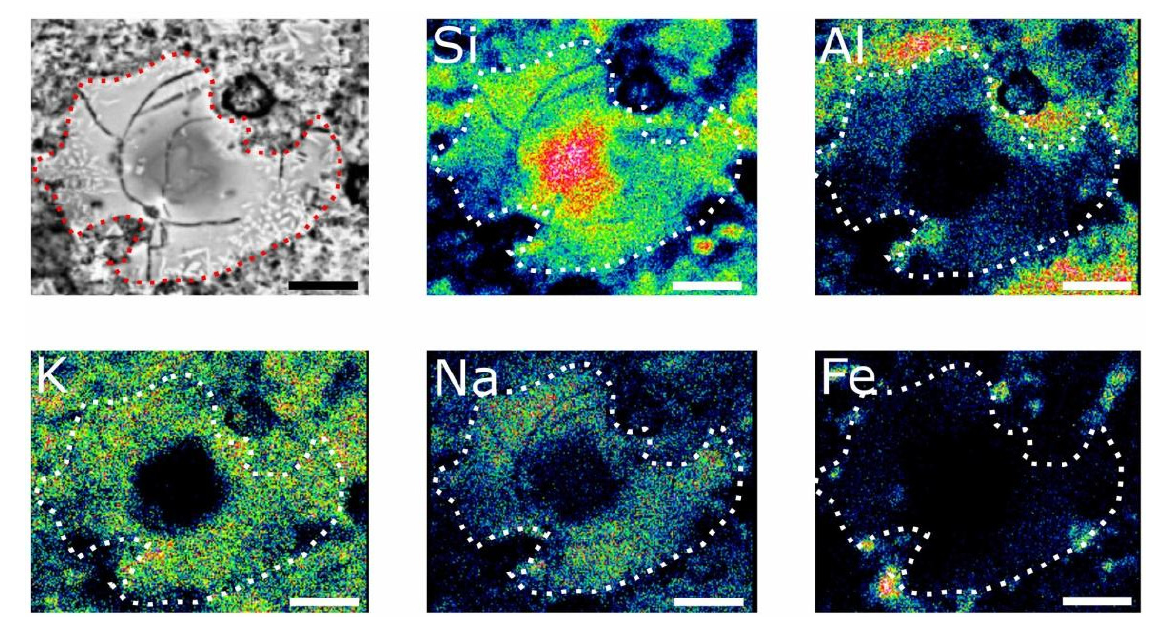
Figure 5. BSE image of altered quartz clast from the outer edge of the crucible (top left) and element distribution maps. Scale bar corresponds to 40 μ m. Brightness of each map is normalized to its maximum.